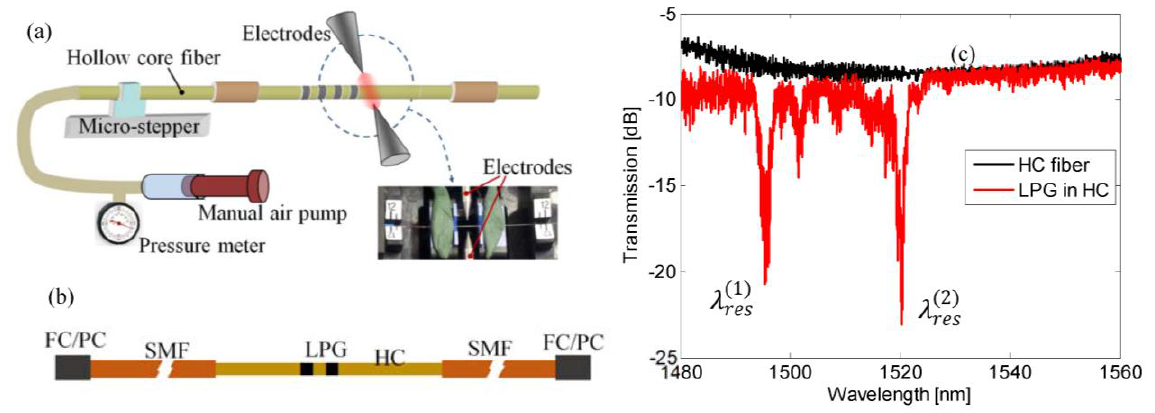
Figure 1. ( a ) Schematic diagram of LPG fabrication experimental setup; ( b ) Schematic view of HC fiber with grating spliced with conventional single mode fibers with FC/PC connectors; ( c ) Transmitted spectra of HC fiber spliced with conventional SMFs with FC/PC connectors with and without